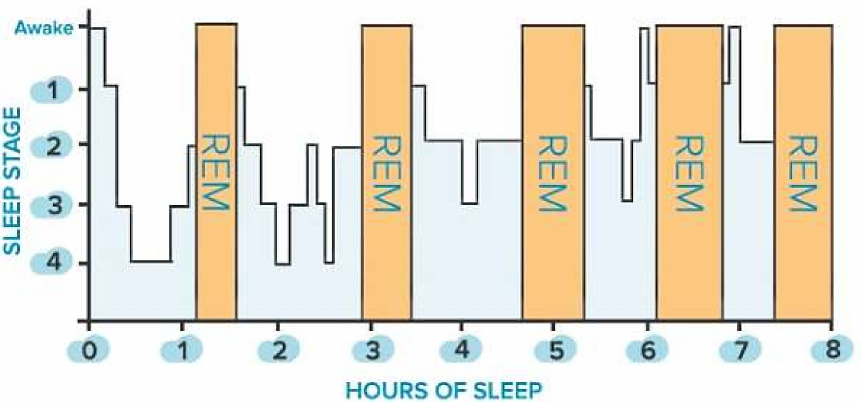
Figure 1. Sleep stages of a healthy adult: non-rapid eye movement (NREM, blue bars) and rapid eye movement (REM, orange bars)